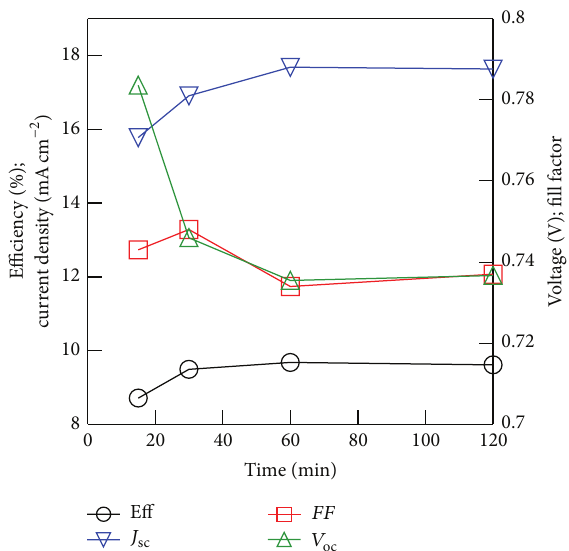
Figure 2: Variations of photovoltaic characteristics of SG1051 dye- sensitized solar cells related to the dye-uptake time. The electrolyte was acetonitrile-based electrolyte for high-efficiency